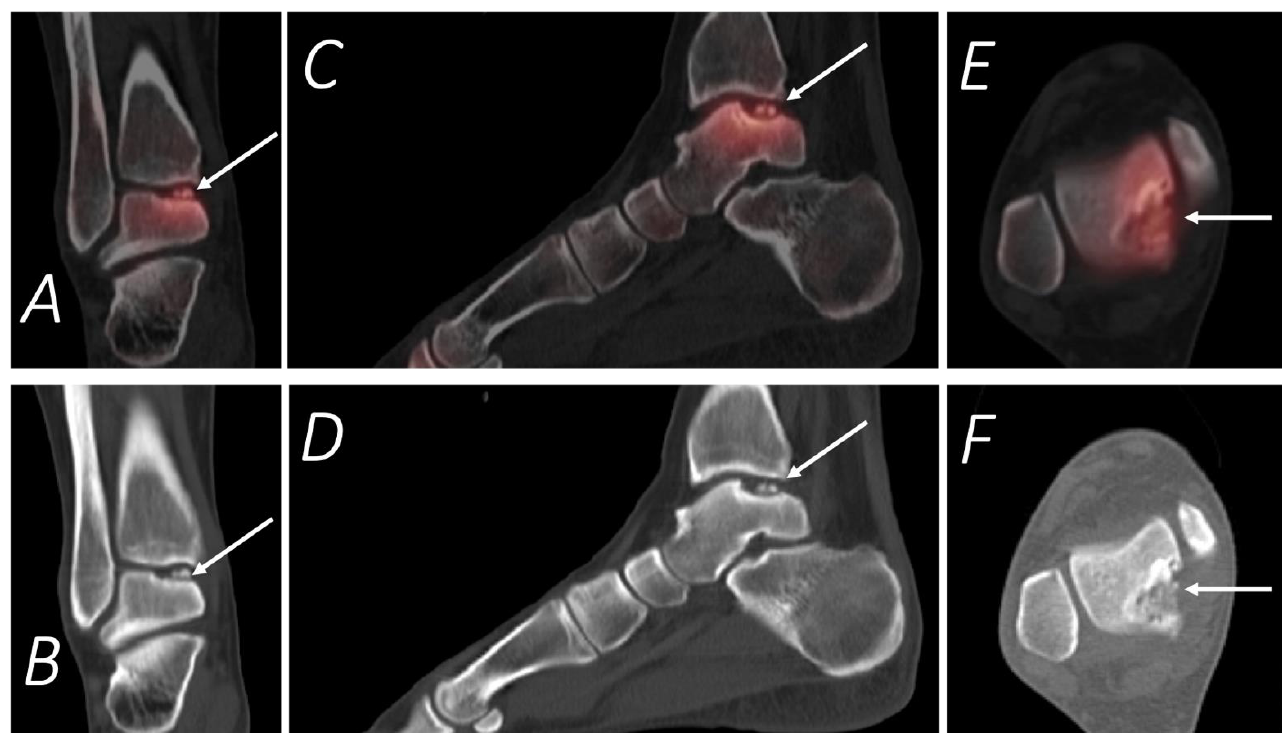
Figure 10. Thirty-two-year-old female being evaluated for chronic but worsening right ankle pain underwent a Tc-99m MDP bone scan with SPECT/CT. Selected upper panel SPECT/CT and corresponding lower panel CT images of the right ankle in coronal ( A , B ), sagittal ( C , D ), and axial ( E , F ) projections are provided. The white arrow denotes a defect in the posteromedial talar articular cartilage and underlying subchondral bone, which corresponded symptomatically with the region of the patient’s pain.